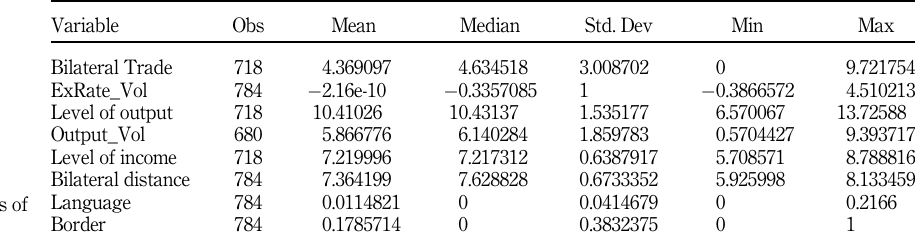
Table 2. Summary statistics of the